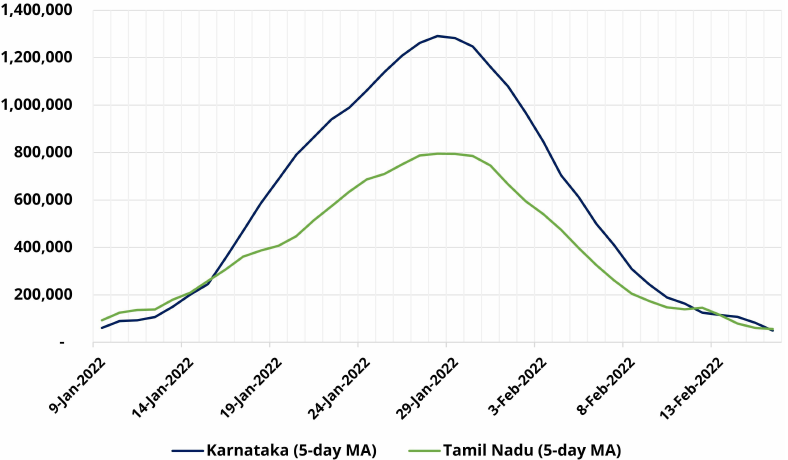
Figure 3. Statistical-model-based infection occurrence estimates for Tamil Nadu and Karnataka for Wave-III from 5th-January-2022 to